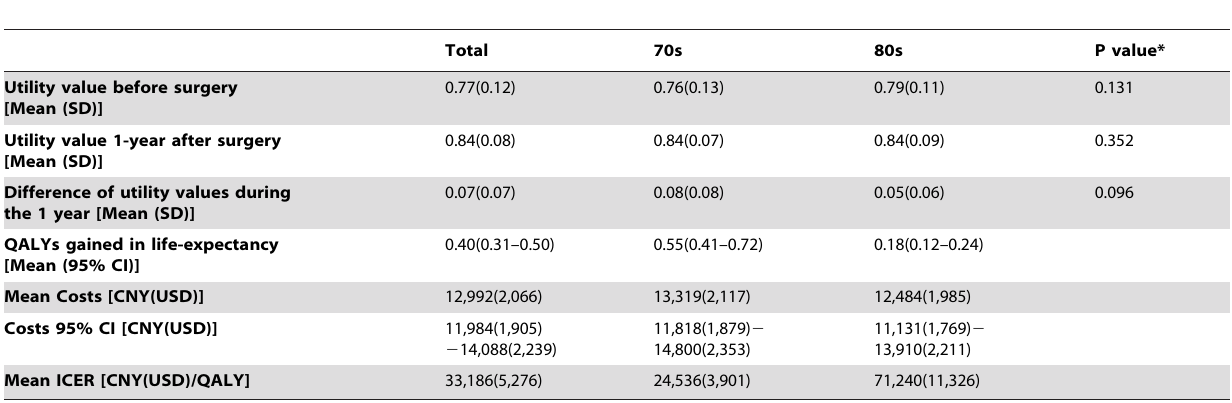
Table 3. Results of the baseline cost-utility analysis for RRD surgery in an elderly population (bootstrap, n =1000).